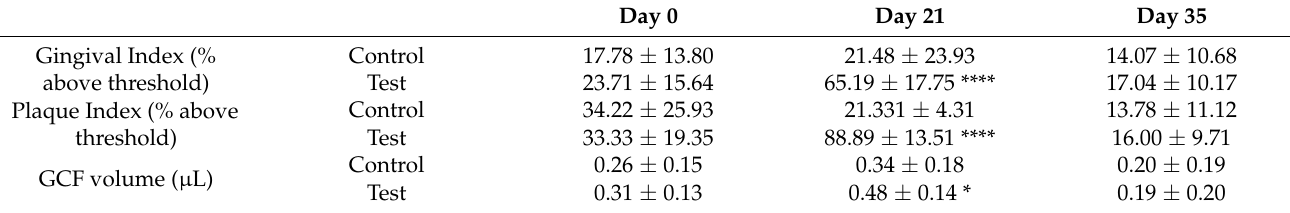
Table 1. Gingival and plaque indices, and GCF volume collected in experimental gingivitis. Percent- age of sites above healthy threshold were measured in all volunteers ( n = 15). GI ranges 0–3 (Loe et al., 1967 [18]); 0 was deemed as absence of gingival inflammation (healthy). The modified Quigley–Hein plaque index ranges 0 to 5; 0 and 1 were deemed to be compatible with health. GCF was collected at non-inflamed (control) and inflamed (test) sites in gingivitis study volunteers. Data are presented as mean ± standard deviation. Statistical test between control and test sites on respective days: paired t -test test. * p < 0.05, **** p < 0.0001. Data are expressed as percentage of data above: 0 for gingival index and 1 for plaque